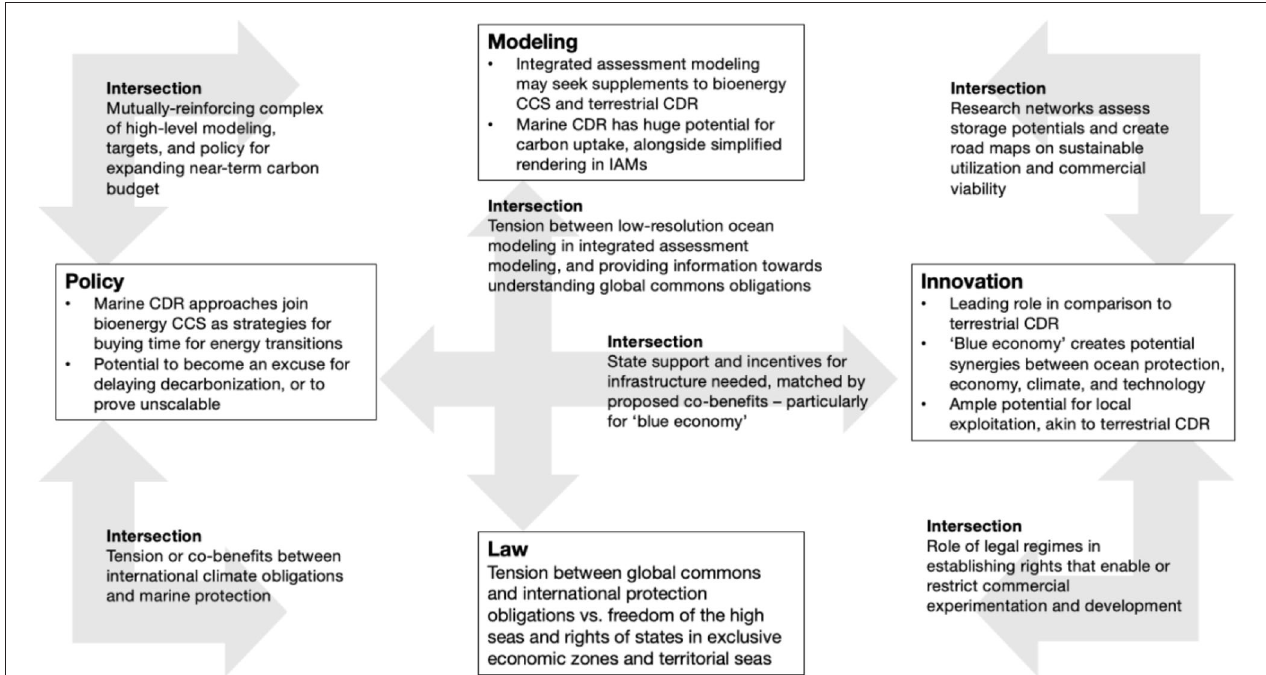
FIGURE 2 | Emerging frontiers for the governance of marine carbon dioxide removal (mCDR)